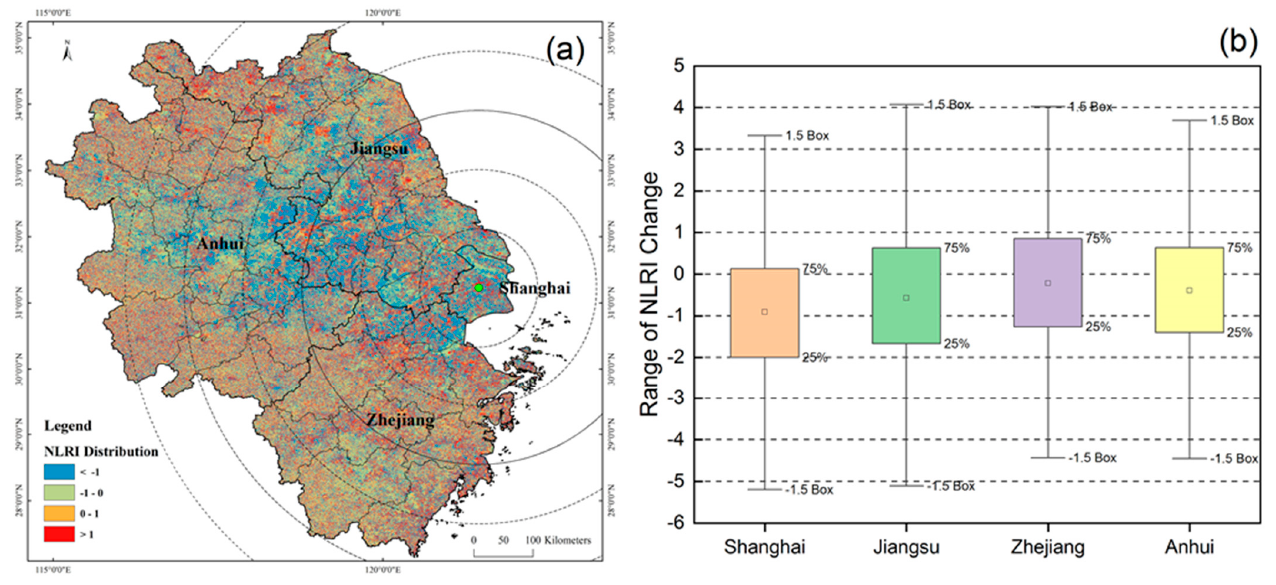
Figure 4. NLRI variation and spatial distribution in the Yang tz e River Delta: ( a ) NLRI spatial distribution; ( b ) NLRI variation of Yang tz e River Delta (Shanghai, Jiangsu, Zhejiang and Anhui).